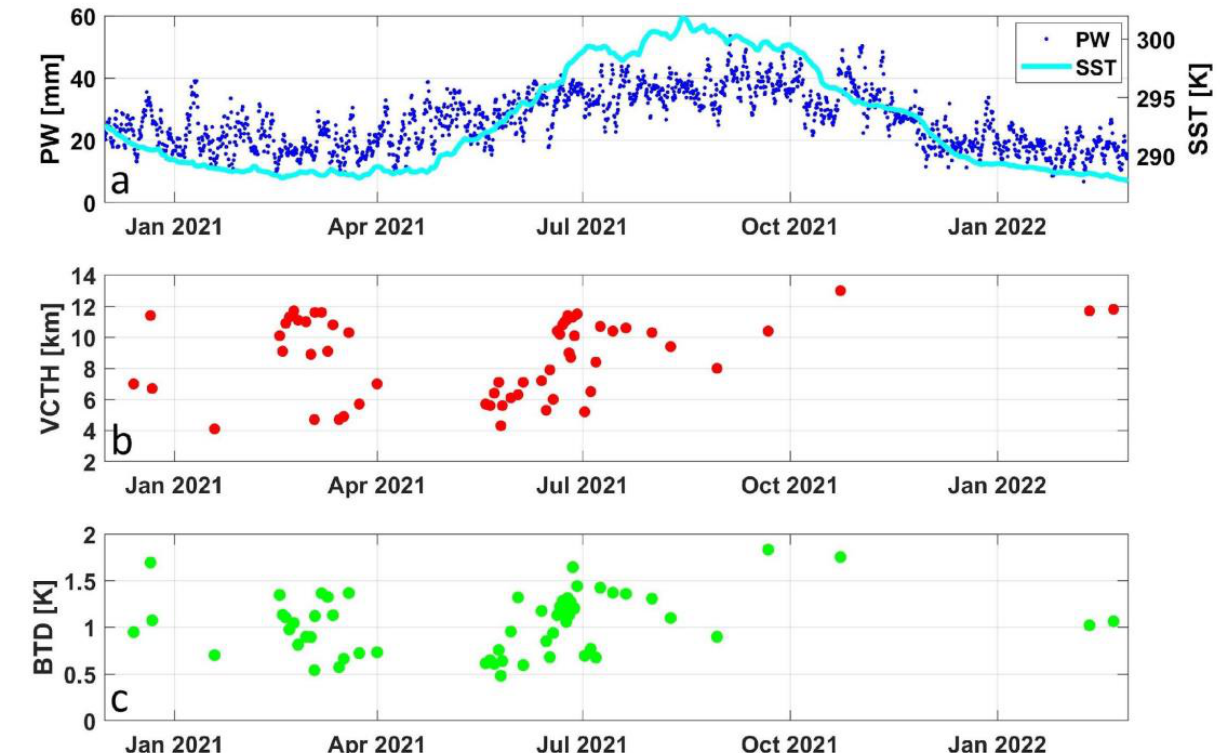
Figure 8. 2020–2022 Etna LF time series of: ( a ) Precipitable Water (PW, [mm]) and Sea Surface Temperature (SST, [K]). ( b ) Volcanic Cloud Top Height (VCTH, [km]). ( c ) BTD threshold used to distinguish between ashy and icy pixels.